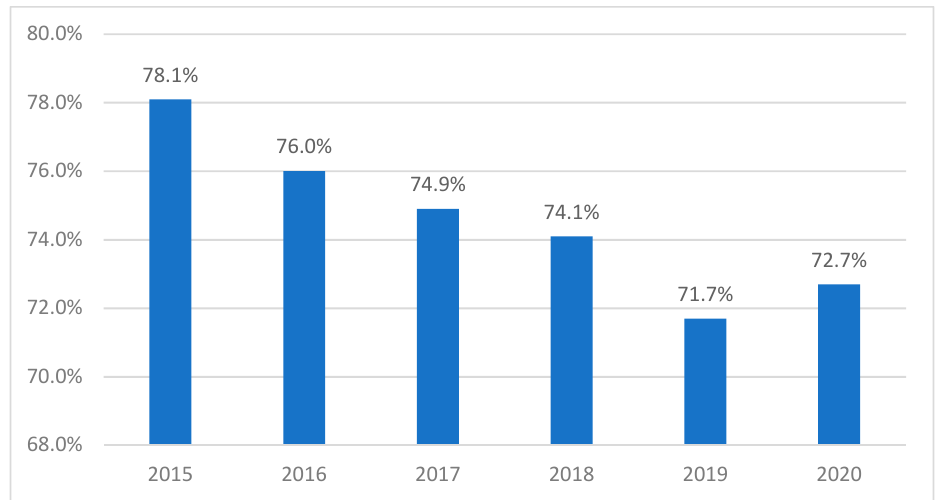
Figure 2. The radio station and its penetration in the Colombian media market. Source: author’s elaboration with data from Asociación Colombiana de Investigación de Medios 2020.